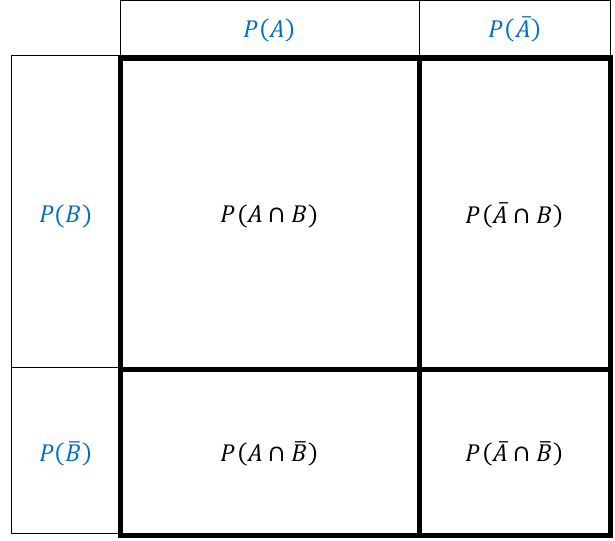
Figure 6. The probability maps of Figure 4 combine into a single map for two independent events